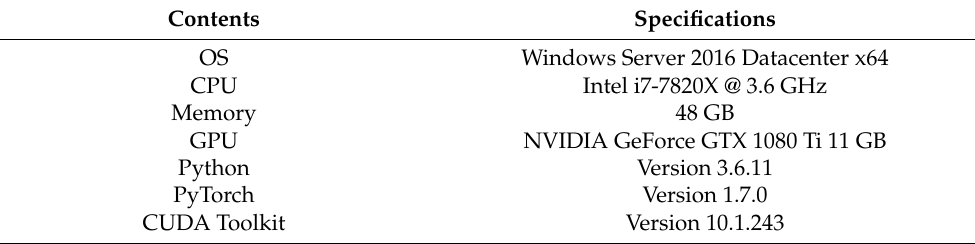
Table 3. Computer environment in which learning and identification took place.